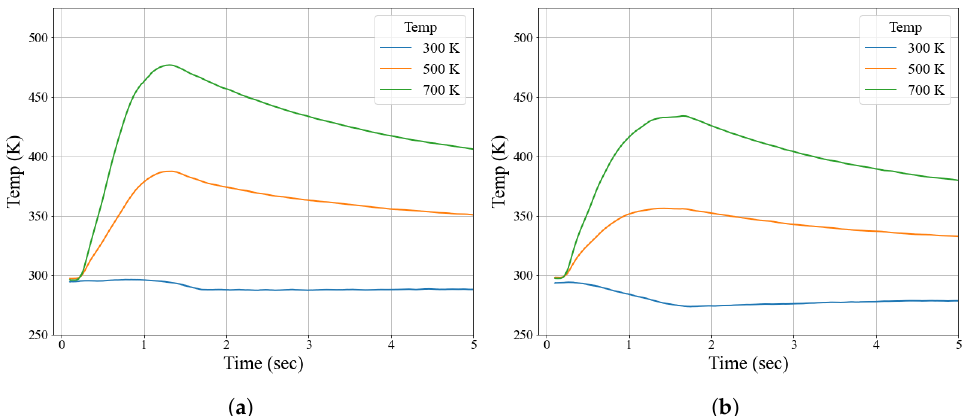
Figure 5. Thermocouple temperature measurements taken at P 0 = 1.6 bar for three different nominal plenum temperatures at Mach 2: ( a ) measured temperature with valves on; ( b ) measured temperature with valves off.